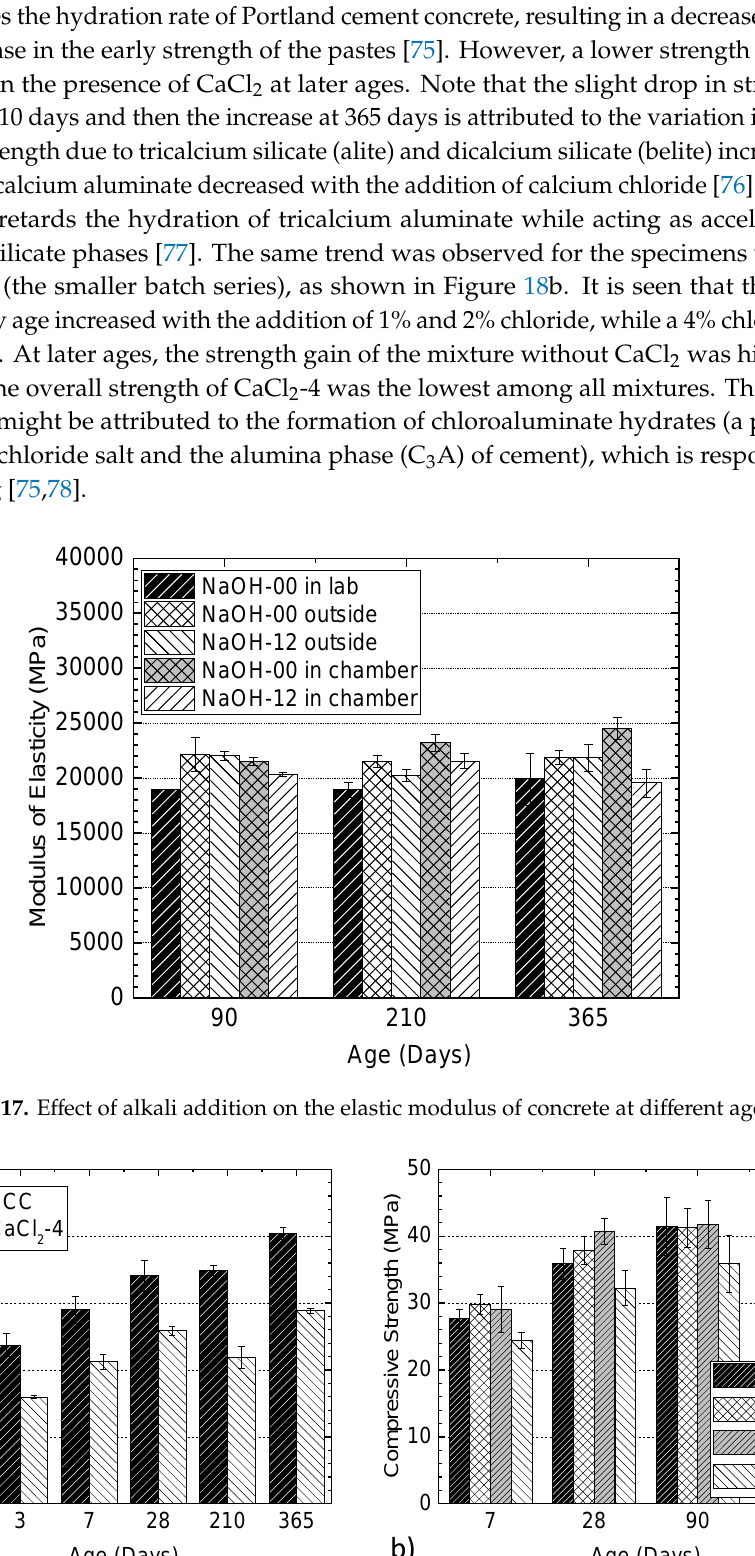
Figure 18. E ff ect of chloride ion on compressive strength at di ff erent ages: ( a ) SCC and CaCl 2 -4 mixtures Figure 18. Effect of chloride ion on compressive strength at different ages: ( a ) SCC and CaCl 2 -4 from the larger batch series and ( b ) CaCl 2 mixtures from the smaller batch mixtures from the larger batch series and ( b ) CaCl 2 mixtures from the smaller batch series.